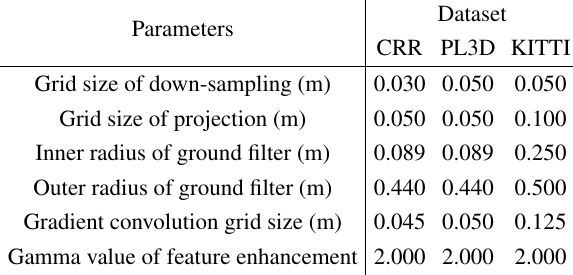
Table 6. Parameters of experiments, where PL3D denotes Paris-Lille-3D